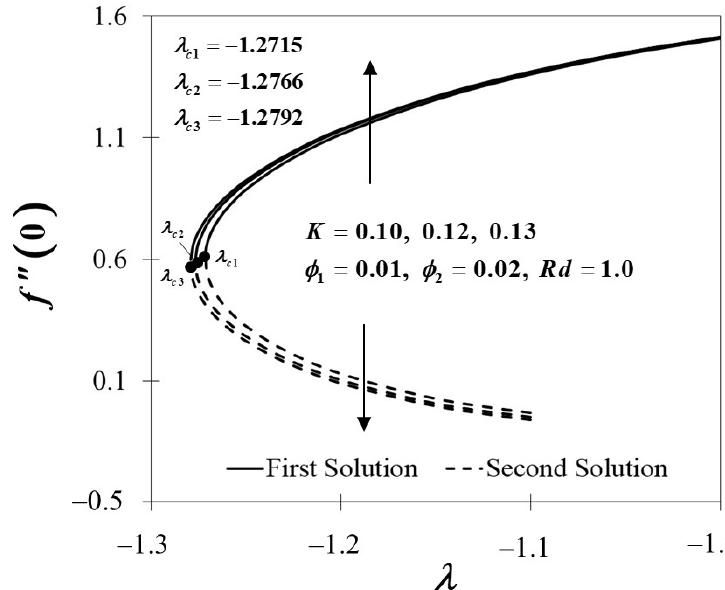
Figure 8. f (cid:48)(cid:48) ( 0 ) towards λ by assorted K .